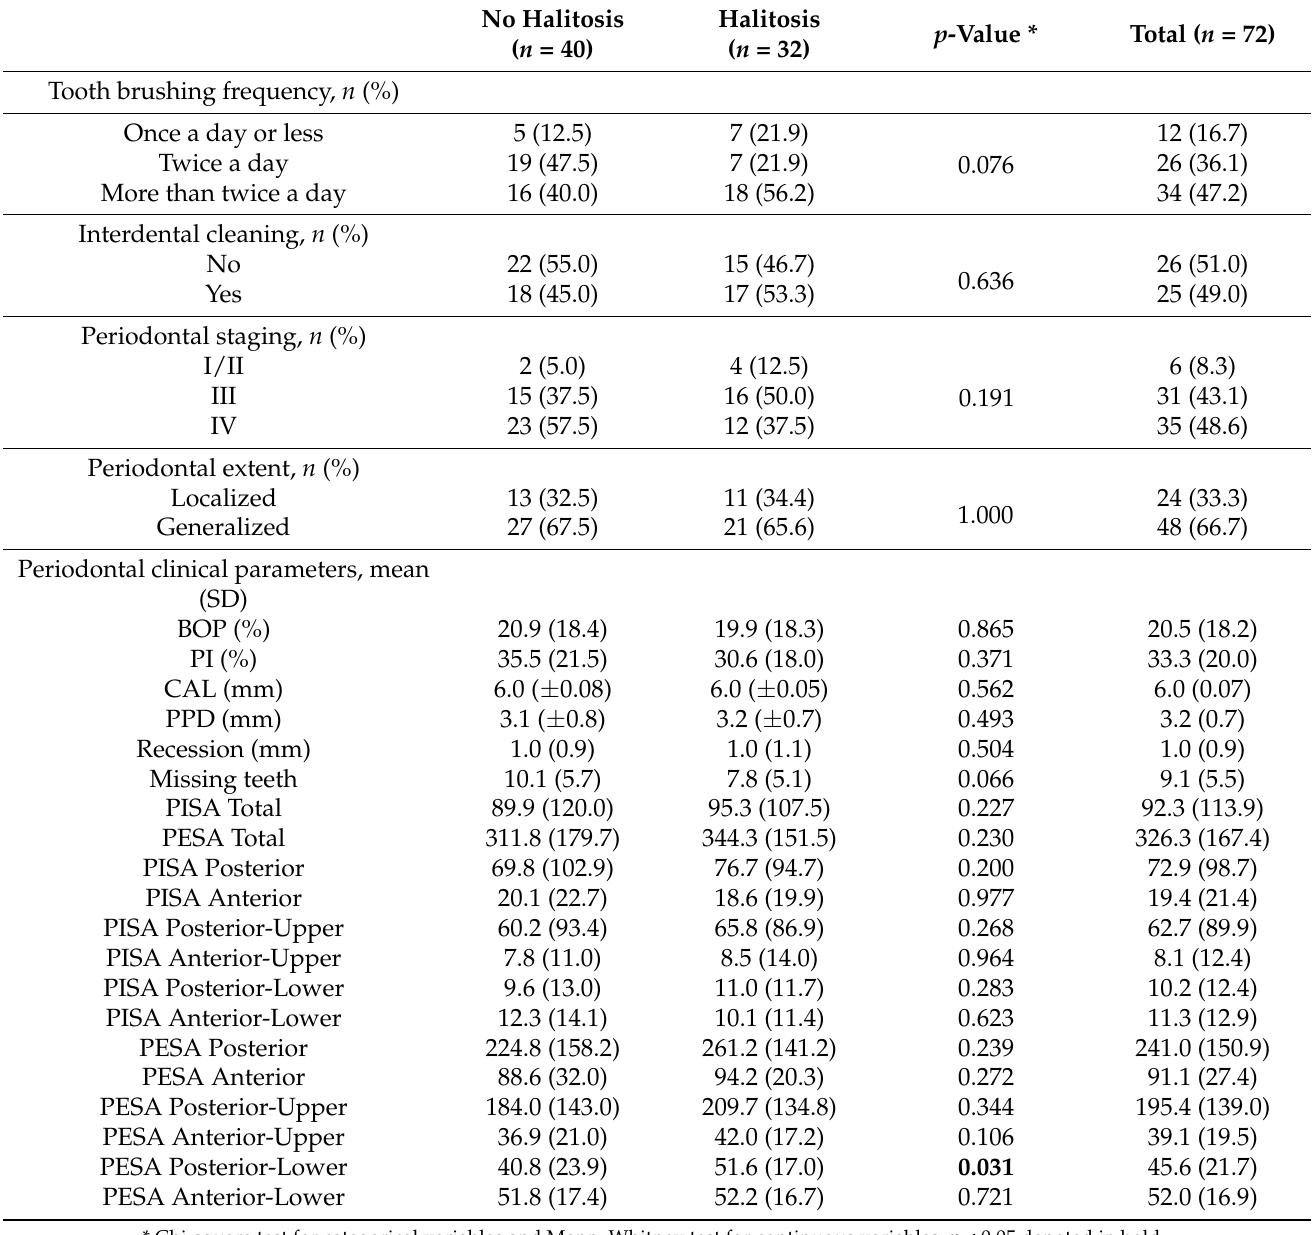
Table 2. Periodontal clinical characteristics, stratified according to halitosis